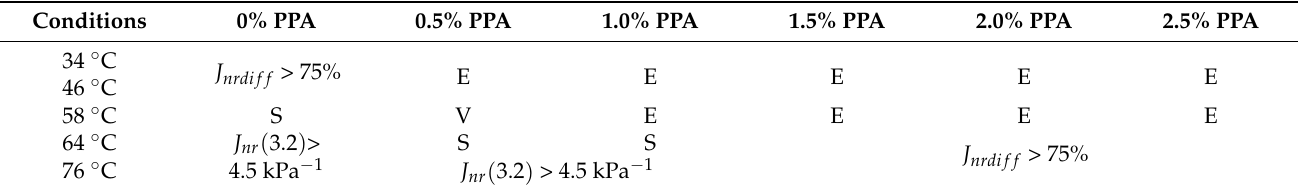
Table 3. Suggested traffic levels for PPA-modified asphalt binders.